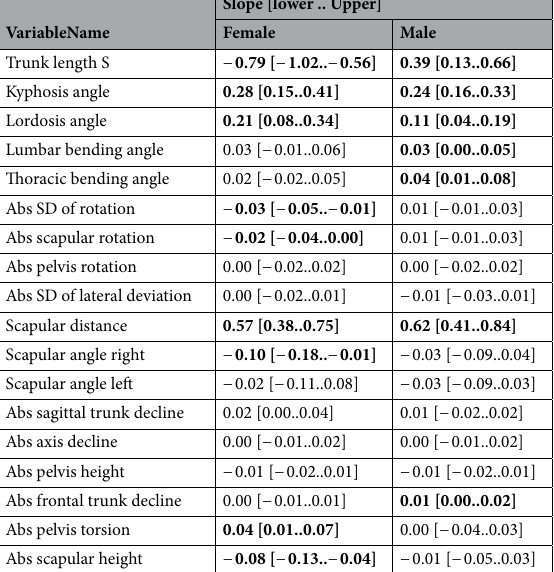
Table 6. Age dependent regression analysis. Slope of the age dependent relationship with the 95% confidence interval of the slope [lower .. upper]. If Abs is placed in front of a parameter, only the absolute values are integrated into the calculations, i.e. only the extent without the direction of movement. Significant variables are highlighted in bold.